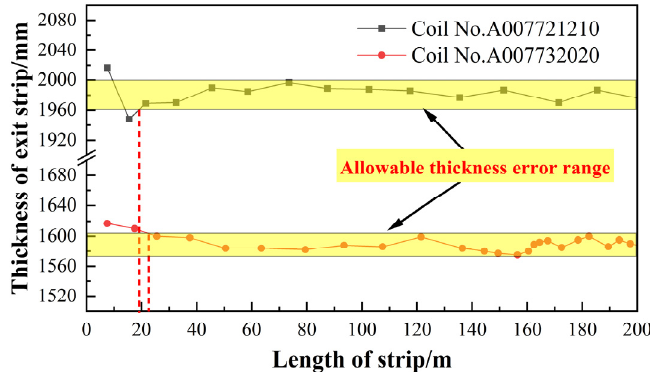
Figure 14. The rolling force of each stand after optimization.